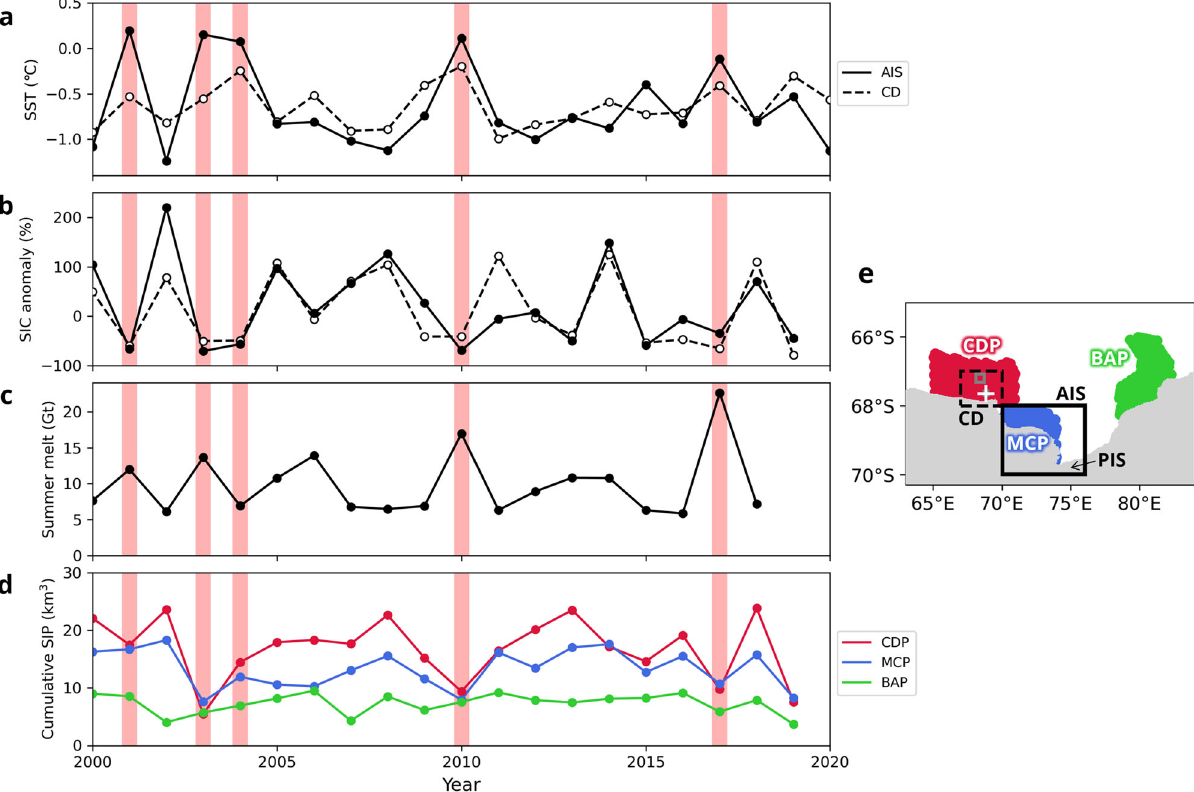
Fig. 3 Interannual variations of sea surface temperature (SST), sea ice concentration, and simulated continental ice melt. a Time series of summer (DJF)-averaged SST in Amery Ice Shelf (AIS; solid) and Cape Darnley Polynya (CDP; dashed). Warm years including 2017 are indicated by red shading. b Anomaly of summer-averaged sea-ice extent (in %; normalized by the climatological mean). c Summer glacial melt near the ice front of the AIS/PIS (north of 70°S; from January to May). d Initial cumulative sea-ice production (from Day of Year 0 to 80) in CDP, Mackenzie Polynya (MCP), and Barrier Polynya (BAP). The corresponding locations are indicated in panel e , where solid and dashed rectangles are AIS and CDP,